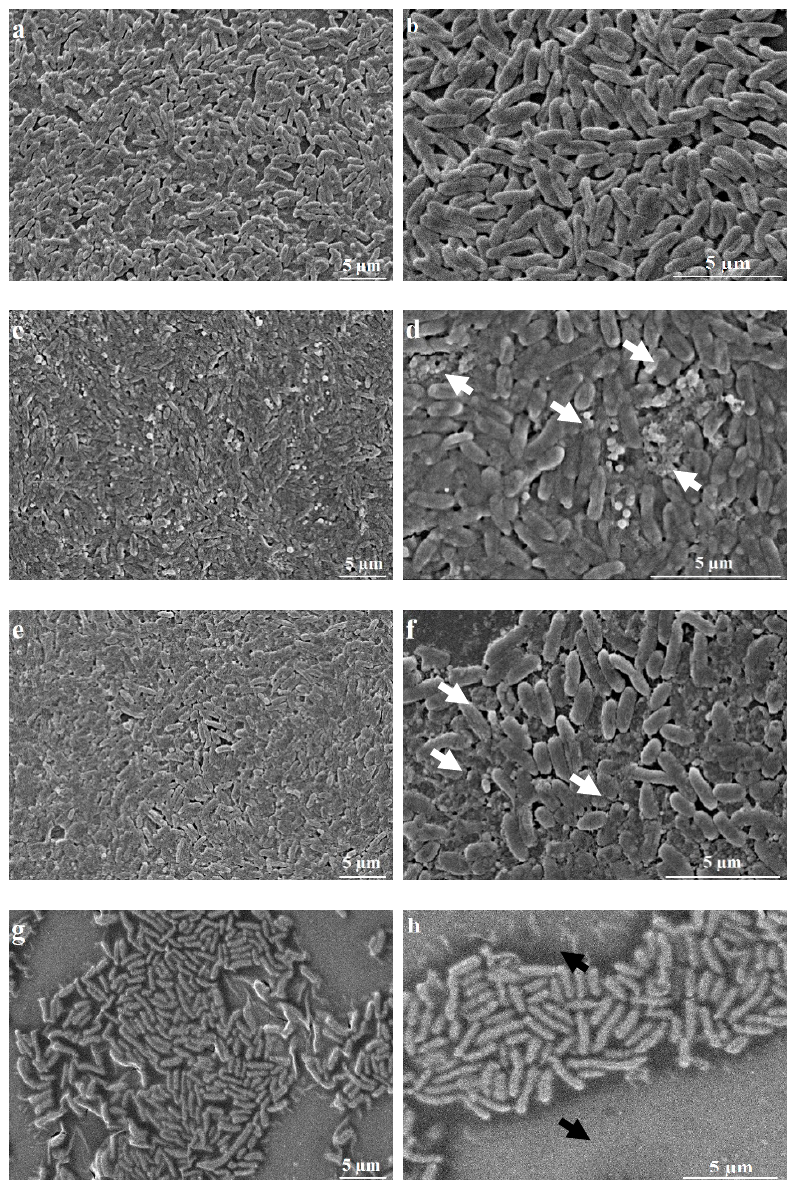
Figure 1. SEM images of C. violaceum growth in normal conditions ( a , b ), in the presence of M. suaveolens ssp. insularis at MIQSC ( c , d ), cis-cis-p -menthenolide at MIQSC ( e , f ) and mintlactone at MIQSC ( g , h ). White arrows in ( d , f ): biofilm matrix degradation; black arrows in ( h ): zones without bacterial development. Scale 5 µm.